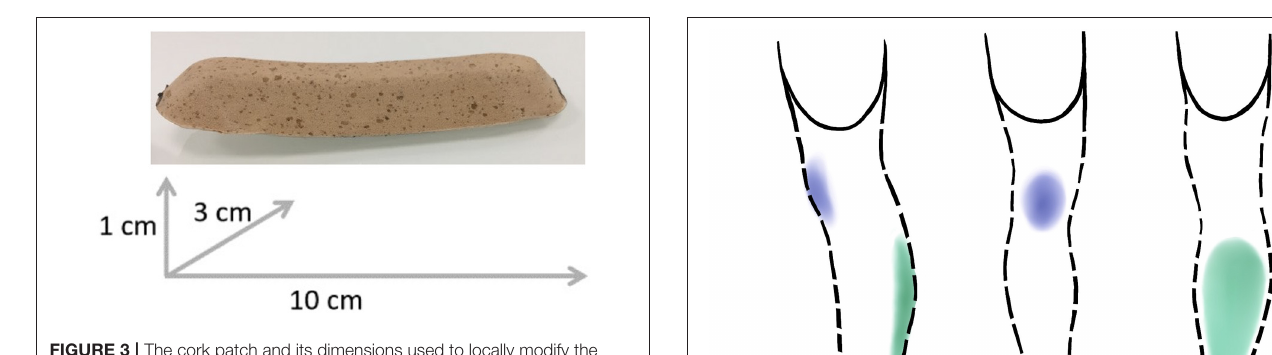
FIGURE 3 | The cork patch and its dimensions used to locally modify the prosthetic interface. It was 10cm long, 3cm wide, and 1cm thick, rounded on the edges that touched the skin to avoid high pressure on the skin at these edges.